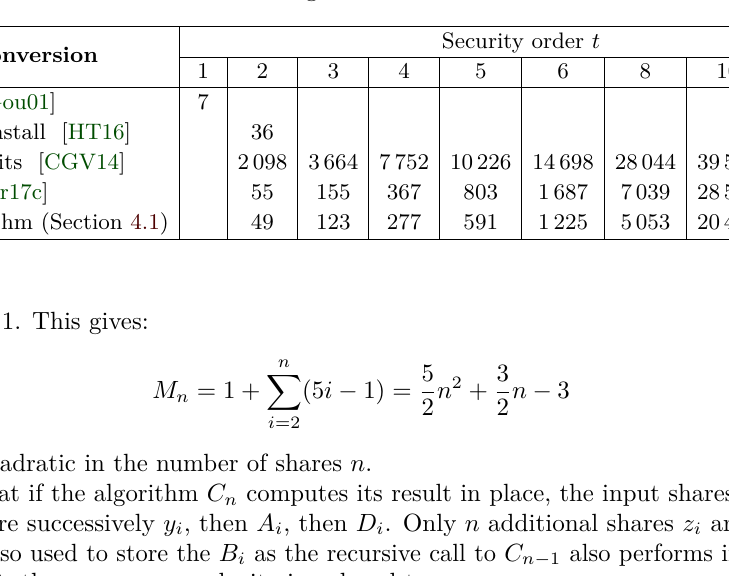
Table 2: Operation count for Boolean to arithmetic conversion algorithms, up to security order t = 12, with n = t + 1 shares. For the Hutter-Tunstall algorithm we have written 36 operations instead of 31 to include the generation of 5 randoms.